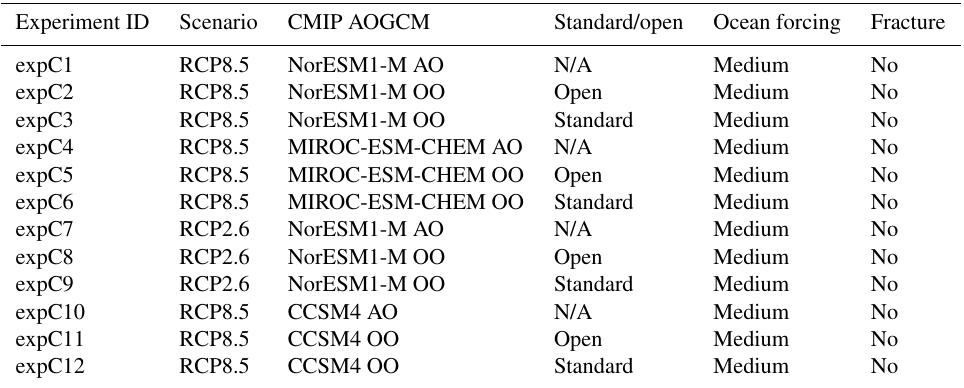
Table A2. Description of ISMIP6 Antarctica Tier 3 simulations, which are performed with ocean-only (OO) or atmosphere-only (AO) forcing, as indicated in the CMIP AOGCM column. N/A indicates not applicable.